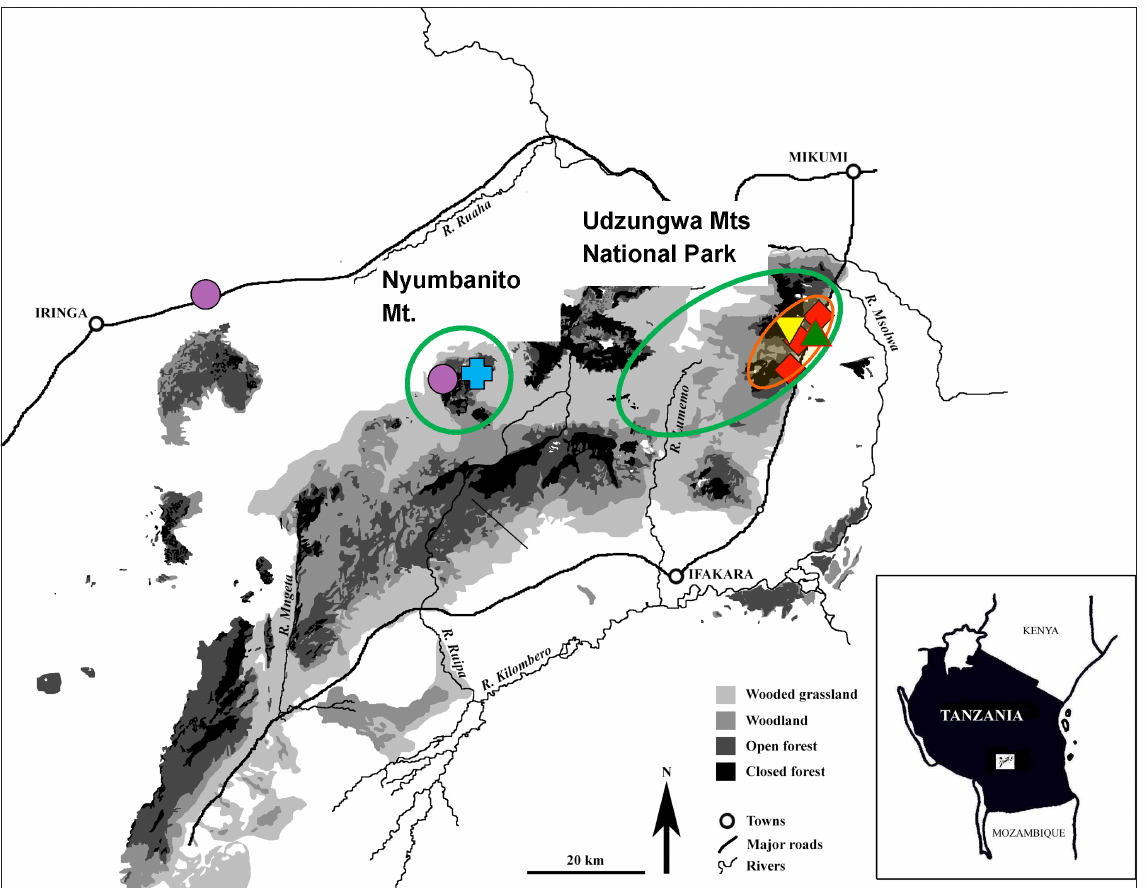
Fig. 1. Map of the Udzungwa Mts, showing the collecting sites for the treated species. Blue cross = Damacornu transversum gen. et sp. nov.; red diamonds = Geotypodon papei sp. nov.; yellow triangle = Helicochetus dimidiatus (Peters, 1855); purple dots = H. mutaba Kraus, 1960; orange oval = Hoffmanides dissutus (Hoffman, 1963) (approximate location); green triangle = Spinotarsus fortehamatus sp. nov. Based on Marshall et al. (2010: fig.